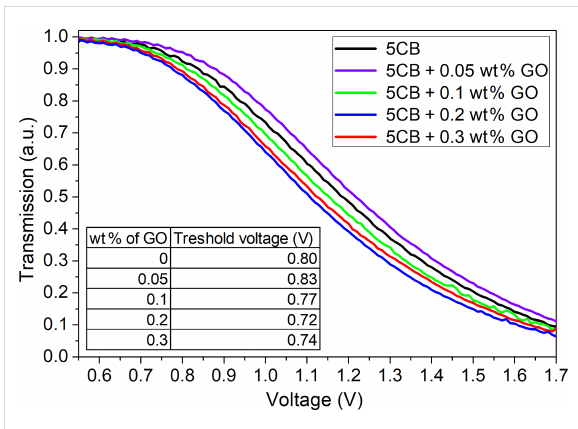
Figure 5: Normalized transmission of light as a function of applied voltage for the pure 5CB and the 5CB-GO suspensions at the different concentrations. The inset shows the threshold voltage U th-EO depen- dence of the GO concentration.